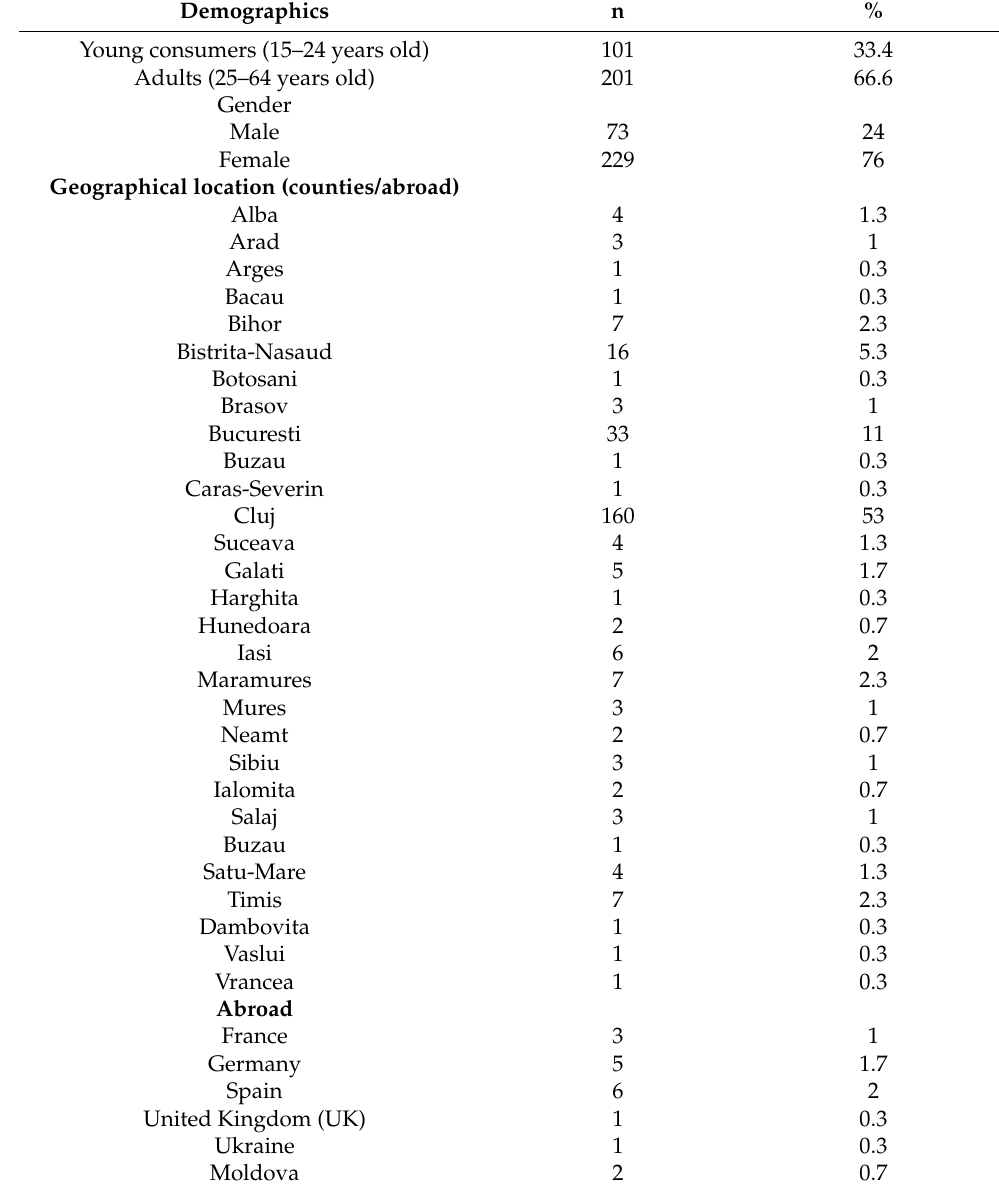
Table 1. Demographic characteristics of study